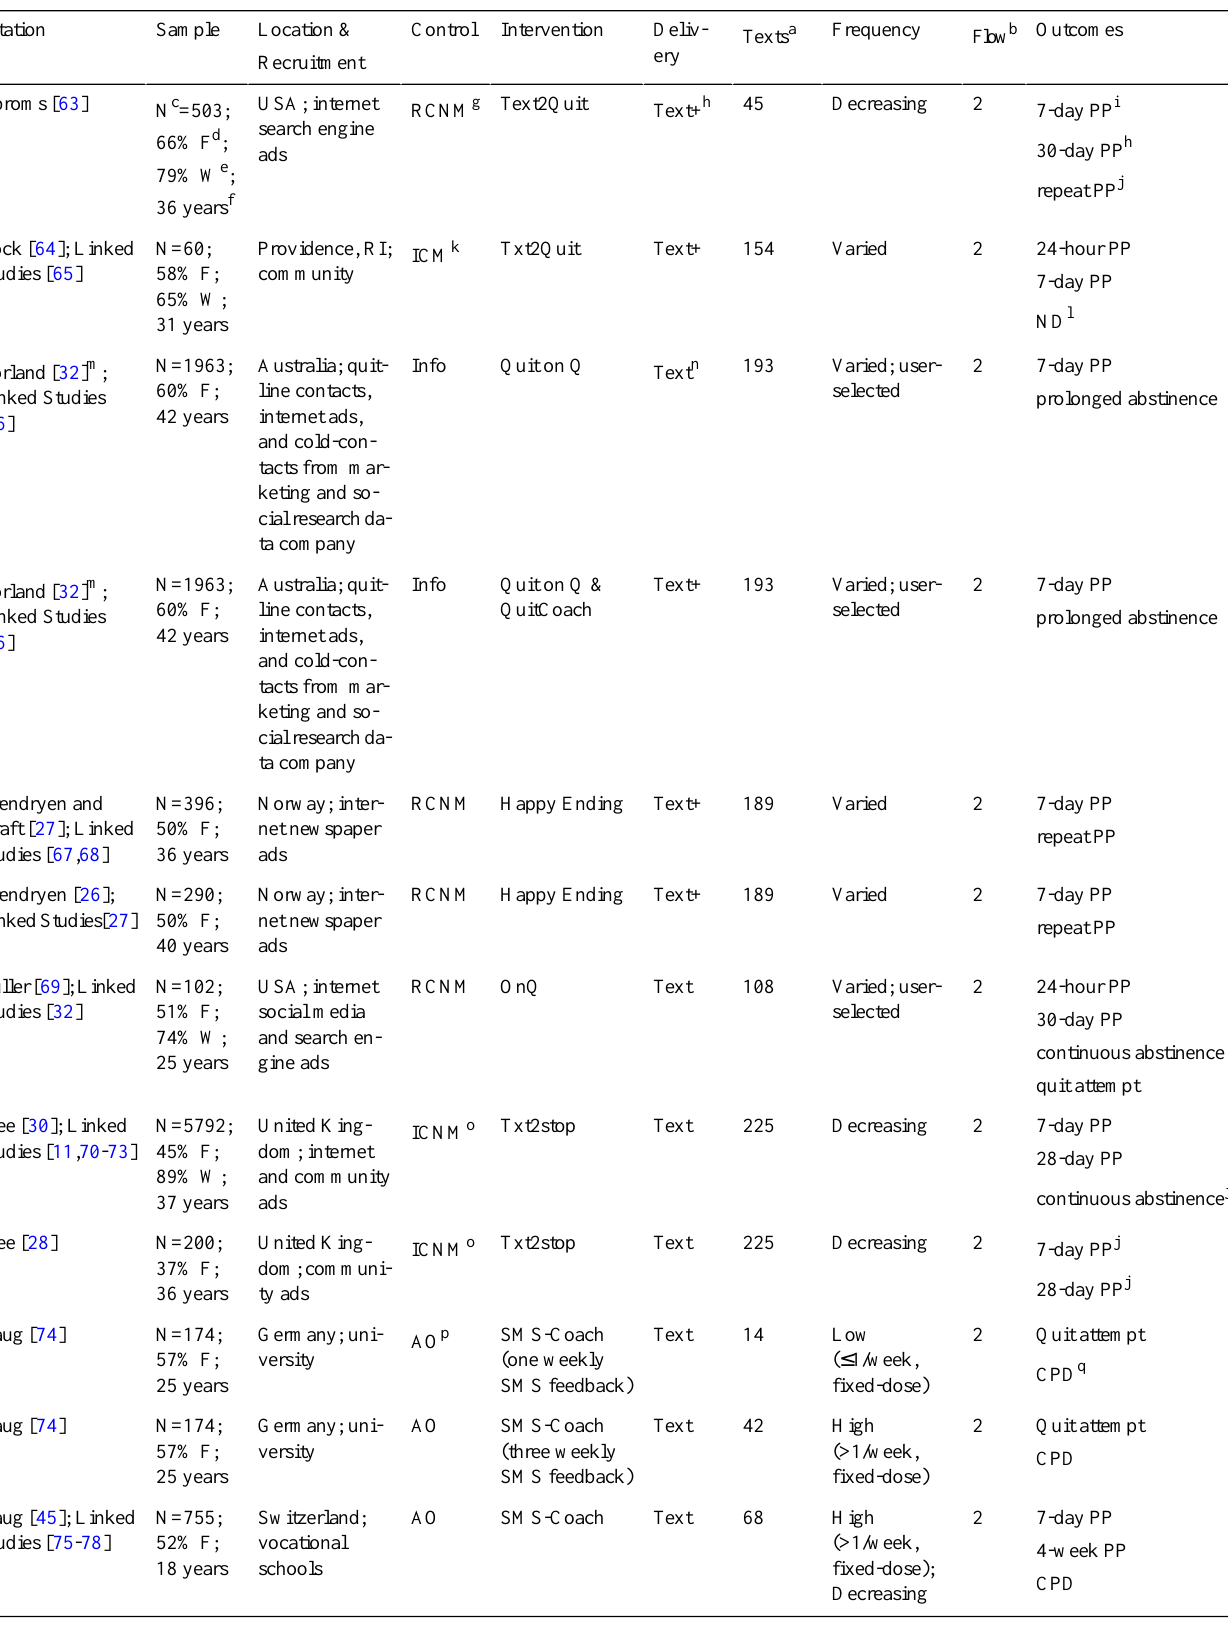
Table 1. The study, sample, and intervention characteristics for the 20 studies (22 interventions) included in the